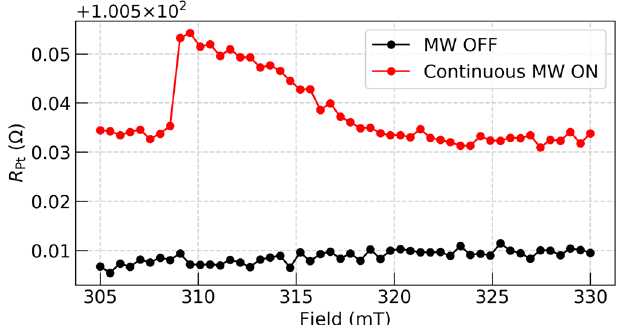
FIG. 6. Measured R under continuous microwave excitation Pt on (red) and off (black) at 6 dBm and 5.11 GHz. The background level increases by 25 m Ω due to the microwave heating. In addition to that, the magnetic resonance, represented by the foldover shape on the red curve due to the strong excitation power, also increases R Pt